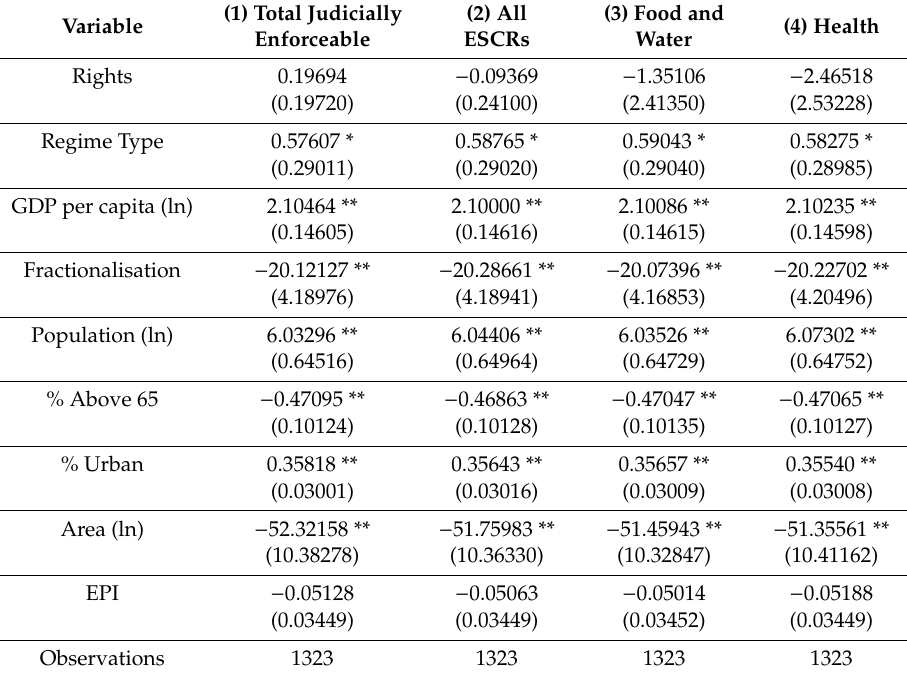
Table 2. Economic and Social and Cultural Rights (ESCRs) & Basic Water Access,